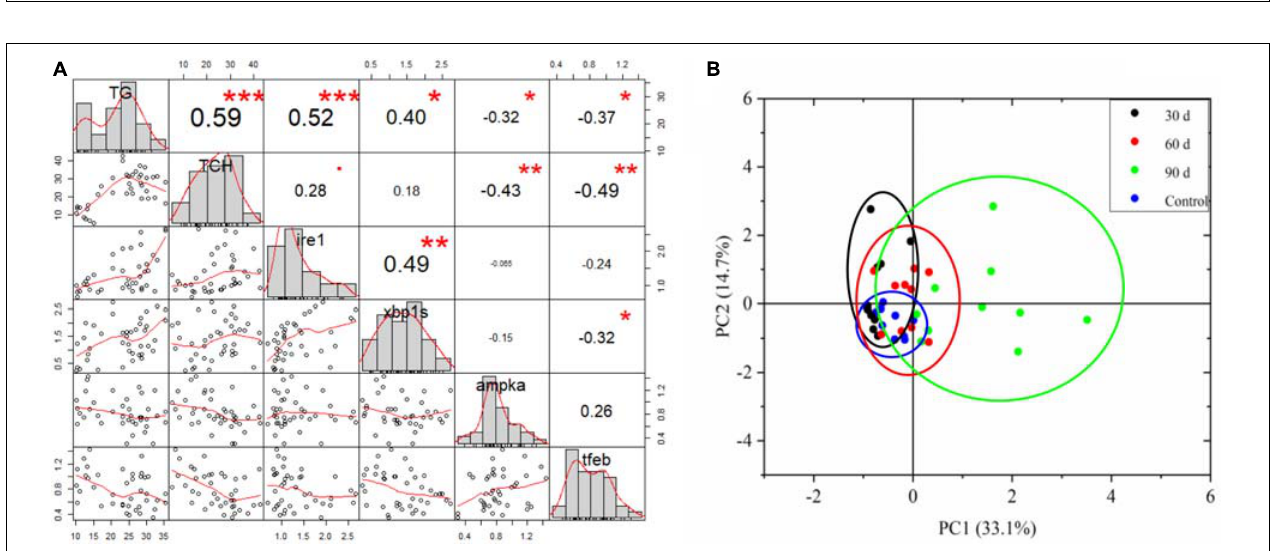
FIGURE 8 | Correlation analysis and principal component analysis (PCA). (A) Relationship between hepatic lipid content and ER stress and autophagy, hepatic lipid mainly consisted of TG and TCH. (B) PCA score plot for all markers measured in tilapia fed control diet and HFD after 30, 60, and 90 days.